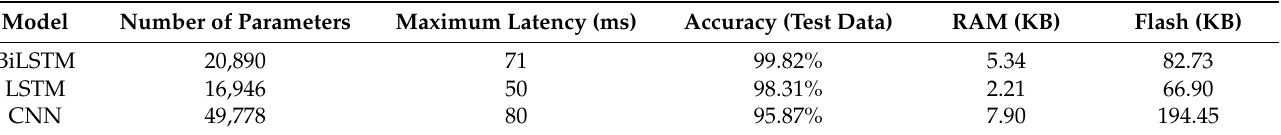
Table 2. Comparison of the studied classification algorithms for finger-writing recognition.